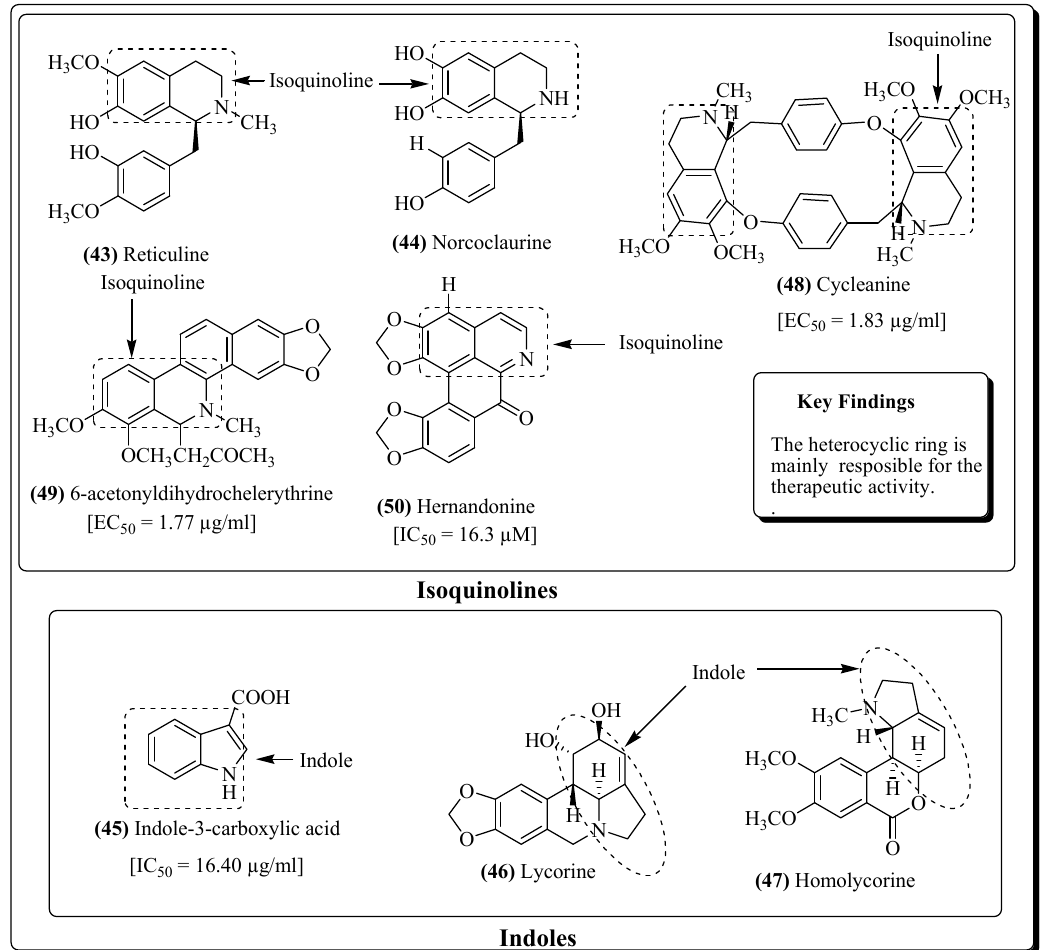
Figure 11. More alkaloidal compounds possessing anti-HIV activity.